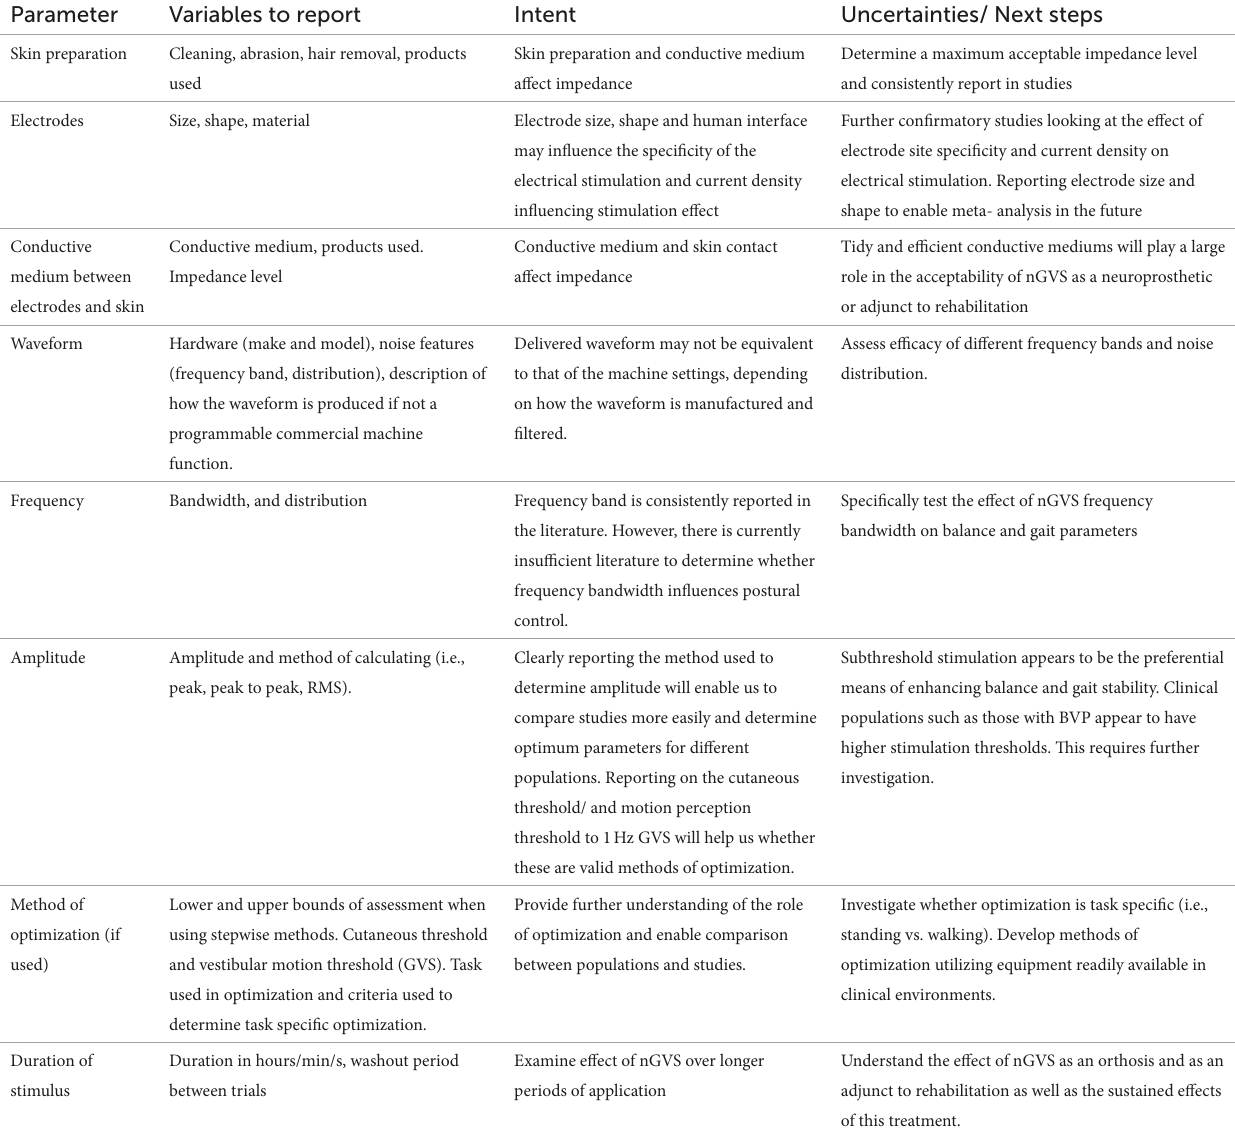
TABLE 7 Key nGVS parameters for